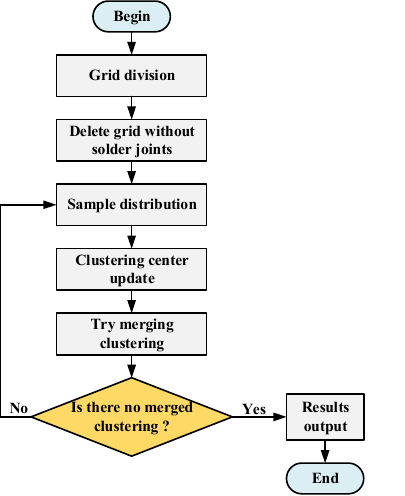
Figure 15. Algorithm full coverage processing frame generation algorithm flow.